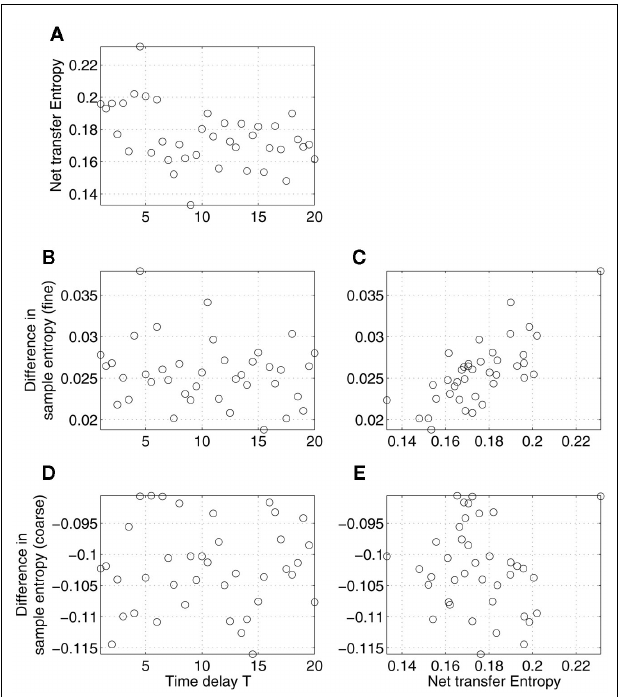
FIGURE 6 | Effects of the strength of coupling (parameter ∈ ) on the relations between differences in sample entropy between coupled Rössler’s oscillators and net information transfer between them. Specifically, net transfer entropy (A) and differences in sample entropy estimated at fine (B) and coarse (D) time scales are given as functions of the coupling strength ∈ . Complexity and transfer entropy were estimated based on the signals x 1 and x 2 , according to the model (12) for the different values of the parameter ∈ with a fixed T . As in Figure 5 , only the relations illustrated in (C,E) can be observed in the MEG data analysis ( Figure 2 ). Note that Figures 2A,B are consistent with (C,E) , respectively, only for relatively weak couplings, with ∈ < 0.08 (B)